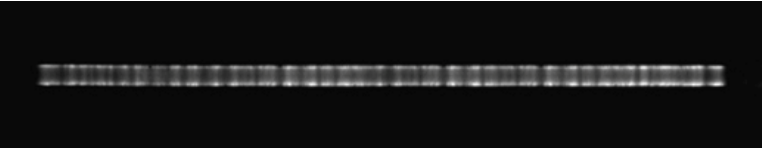
Figure 9. ICCD photo of filamentous discharge, P = 420 W, N 2 = 150 mL/min, gas mixture = 2 L/min. Exposure time: 100 μ s.